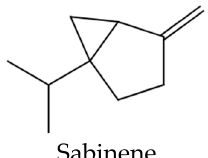
Figure 7. The main component of Juniperus horizontalis essential oil.